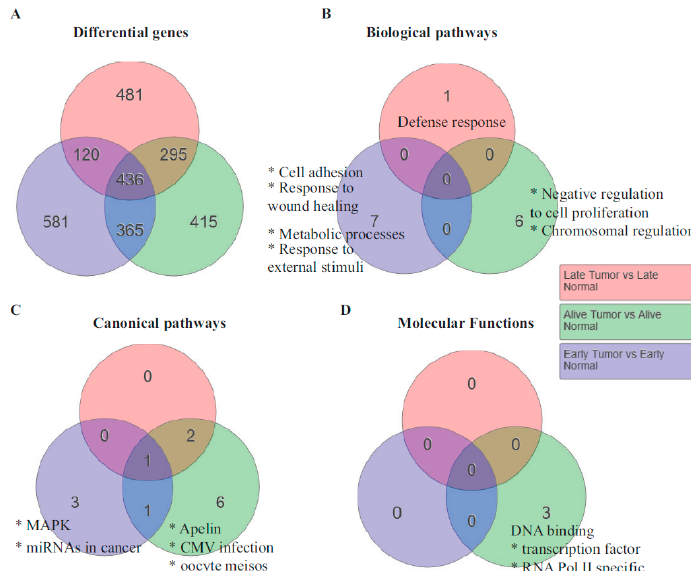
Figure 3. Pathway analysis of the differentially expressed genes with samples segregated based on survival. The numbers in the figures represent the number of genes ( A ) and the enriched pathways ( B – D ). The different pathways are represented in each Venn circle. Survival was defined as those patients who survived less than 30 months post-diagnosis (early), more than 30 months (late), and were alive at the time of data collection (alive).